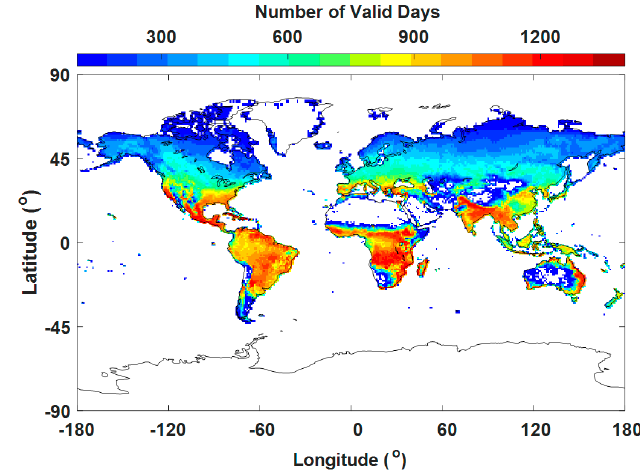
Figure 3. Valid days of VIIRS at a grid of 1° × 1° during the study period (total of 1497 days from 23 January 2013 to 28 February 2017).